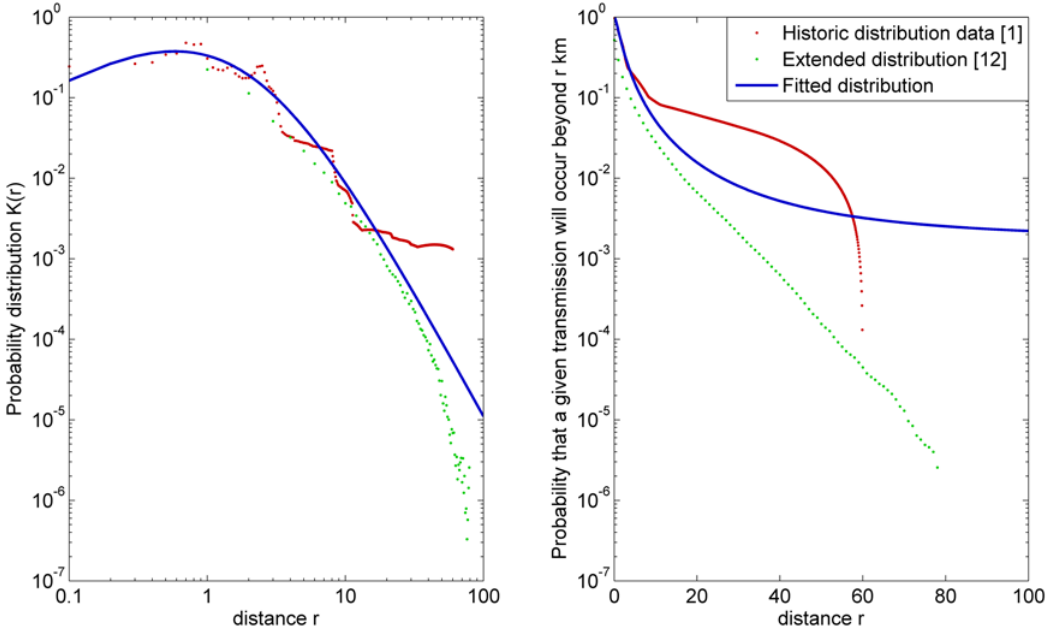
Figure 3. The probability of a given transmission occurring (left) at a given distance and (right) beyond a specified distance for the model transmission distributions and those based on the historic transmission kernel [ 1 ] , and an extended transmission kernel [ 12 ] , derived from the 2001 UK outbreak.